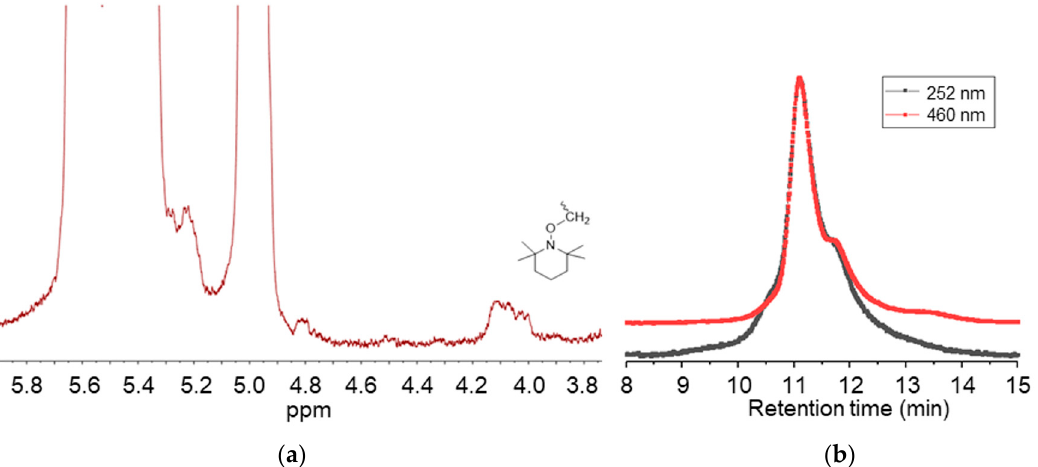
Figure 2. 1 H-NMR spectrum in the region 3.8 – 5.9 ppm of the macroinitiator MI ( a ), and GPC curves of the macroinitiator MI obtained with the UV detector at λ = 252 nm and λ = 460 nm ( b ).